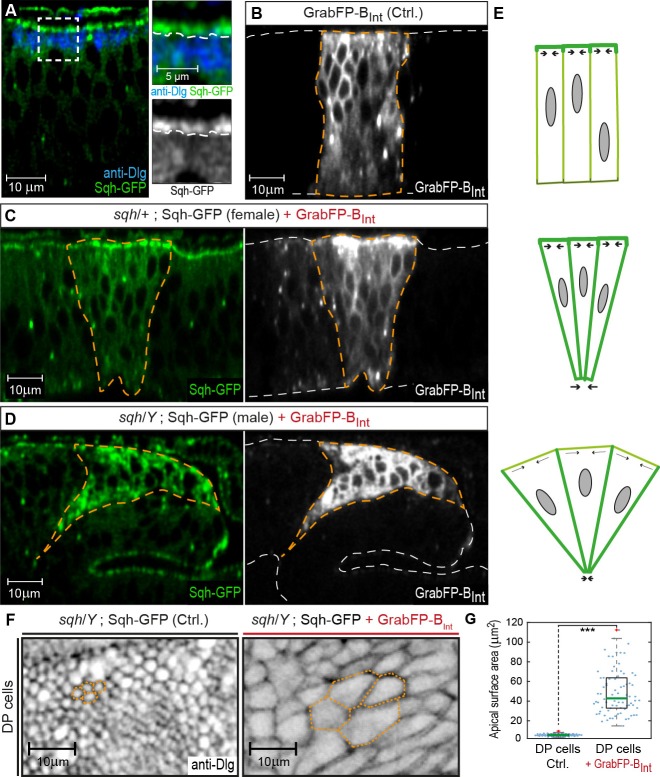
GrabFP-BInt-mediated Sqh-GFP mislocalization results in changes of DP cell shape.(A) Optical cross-section of a wing disc expressing Sqh-GFP (green), stained for Dlg (blue). In the magnifications, the junctional level is marked by a dashed line. (B–D) Optical cross-sections of wing discs expressing GrabFP-BInt (grey) in the patched domain (marked by dashed orange line, ptc::Gal4) either alone (Ctrl., (B) or together with Sqh-GFP (green) in heterozygous sqh females (C) and hemizygous sqh males (D). Sqh-GFP mislocalization causes a drastic increase of basolateral Sqh-GFP (C–D). Mislocalization of Sqh-GFP causes cell shape alterations resulting in a triangular shape of the ptc domain (C–D), compared to the rectangular shape of the ptc domain in control discs (B). The white dashed line marks the apical (top) and basal (bottom) surface of DP cells. (E) Schematic representation of the effect of Sqh-GFP mislocalization. Tension is higher in the apical cortex of columnar cells due to polarization of myosin II activity (top). Mislocalization of Sqh-GFP causes increased basolateral tension, leading to constriction of the basolateral cell area (middle). In sqh hemizygous conditions, the apical surface expands due to decreased apical myosin II activity (bottom). (F) Projections of the junctional level of the DP columnar epithelium of the genotype shown in (D) either in the absence of GrabFP-BInt (left, normal Sqh::GFP localization) or in the presence of GrabFP-BInt (right, mislocalized Sqh::GFP). (G) Quantification of apical surface area as marked in (F). The green line marks the median, statistical significance was assessed using a two-sided Students t-test (***p<0.0005), n ≥ 77.DOI:
http://dx.doi.org/10.7554/eLife.22549.01310.7554/eLife.22549.014Figure 4—source data 1.Source data for apical surface area.